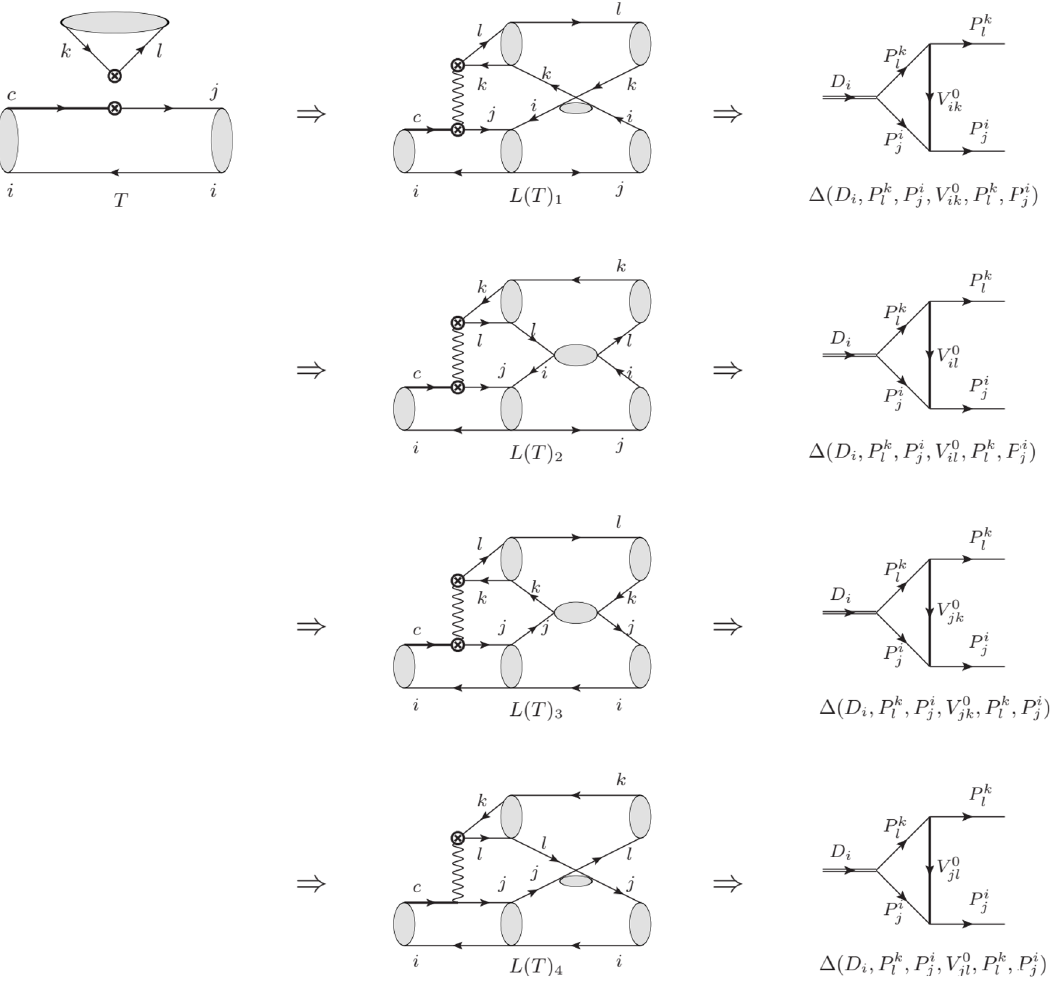
Figure 7 . Topological diagram ⇒ Topological-scattering diagram ⇒ Triangle diagram in T ⇒ T transition.